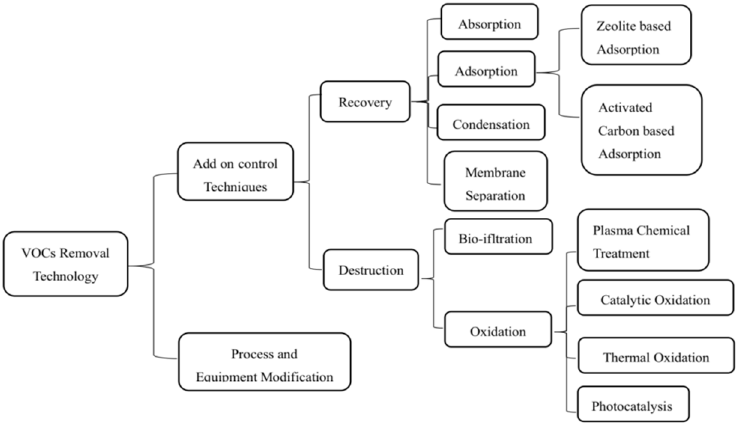
Figure 2. Classification of VOCs control techniques. Reprinted with permission from [26], 2000, Elsevier Ltd.